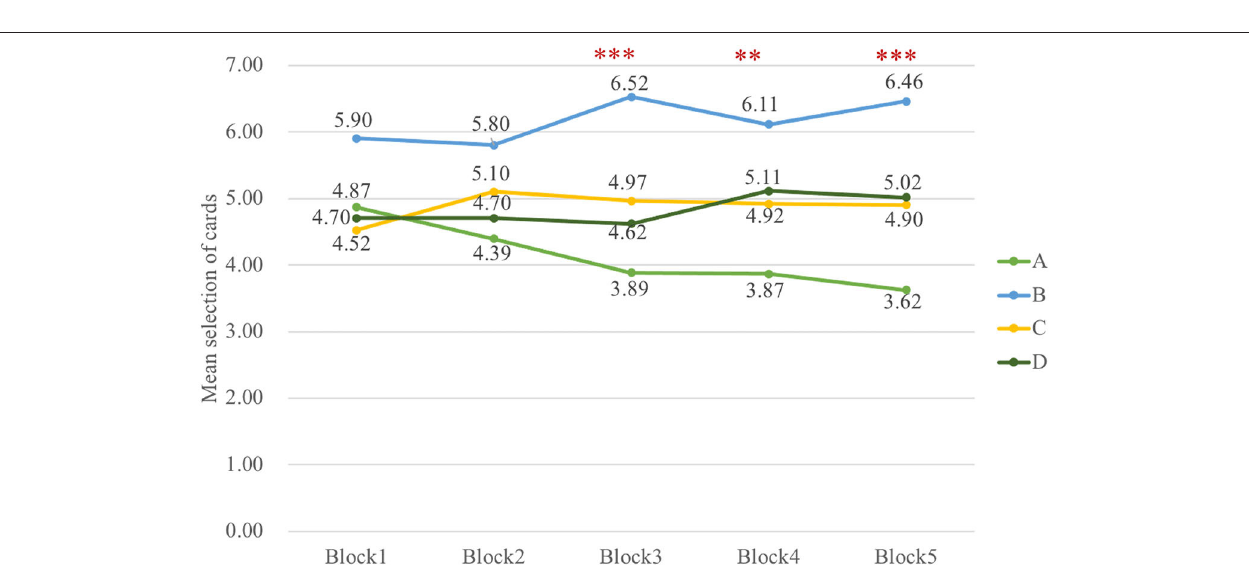
FIGURE 4 | The selective pattern of Sz in five blocks. The number of cards from deck B is significantly larger than deck A over block 3 [ F (3, 493) = 7.18, p < 0.001], block 4 [ F (3, 493) = 4.92, p = 0.002], and block 5 [ F (3, 493) = 7.87, p < 0.001] in Sz. ** p < 0.01, *** p <